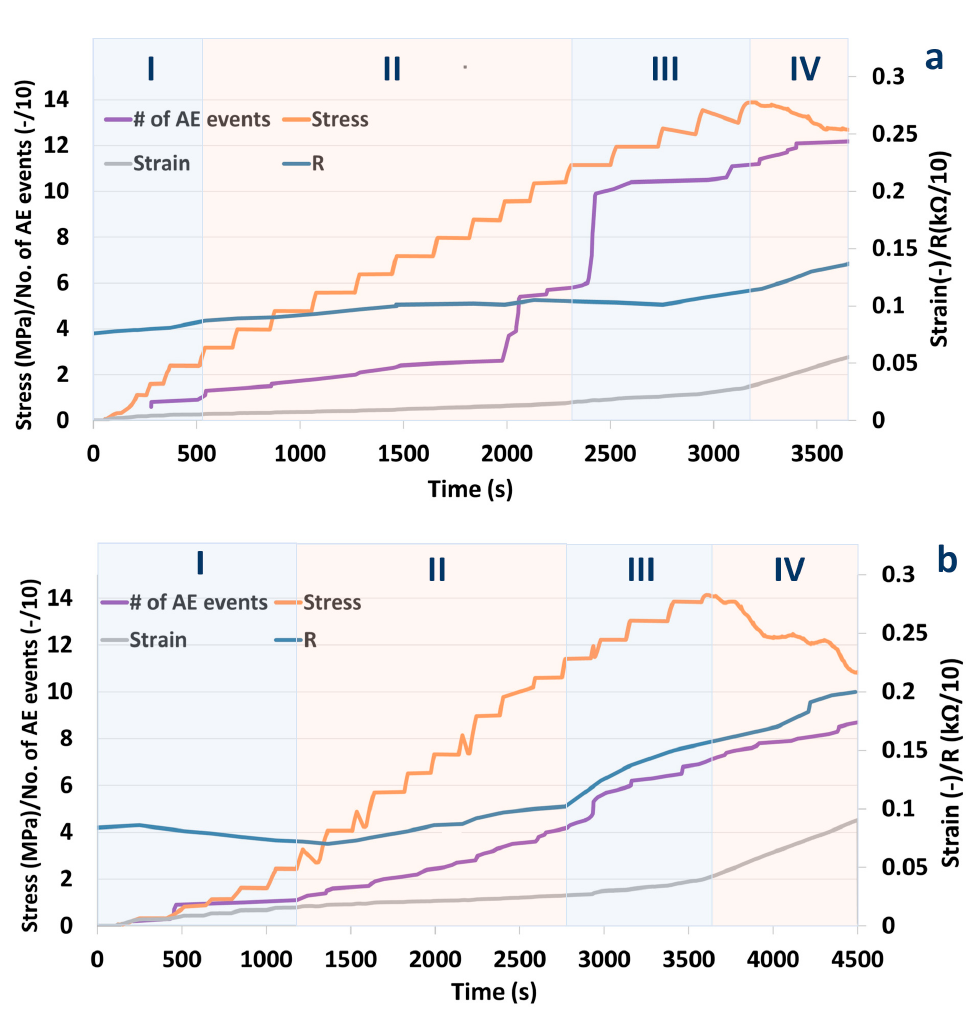
Figure 5. Evolution of stress, strain, resistivity, and the cumulative number of acoustic emission events during uniaxial compression of Sample 1 ( a ) and Sample 2 ( b ).